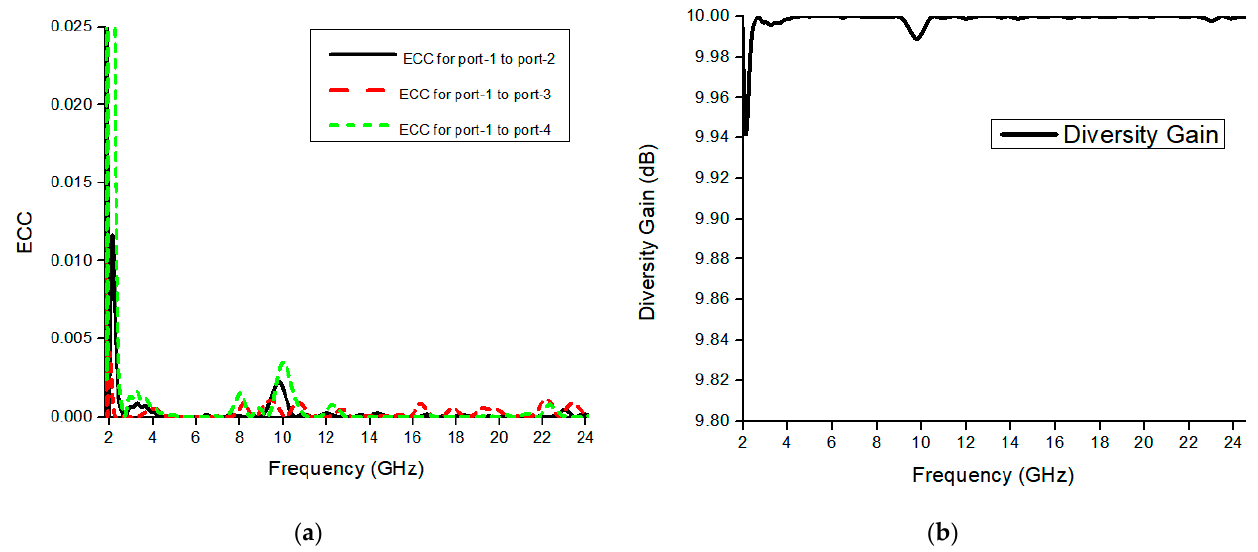
Figure 8. Simulation response of the orthogonal MIMO antenna. ( a ) S-parameters and ( b ) mutual coupling.